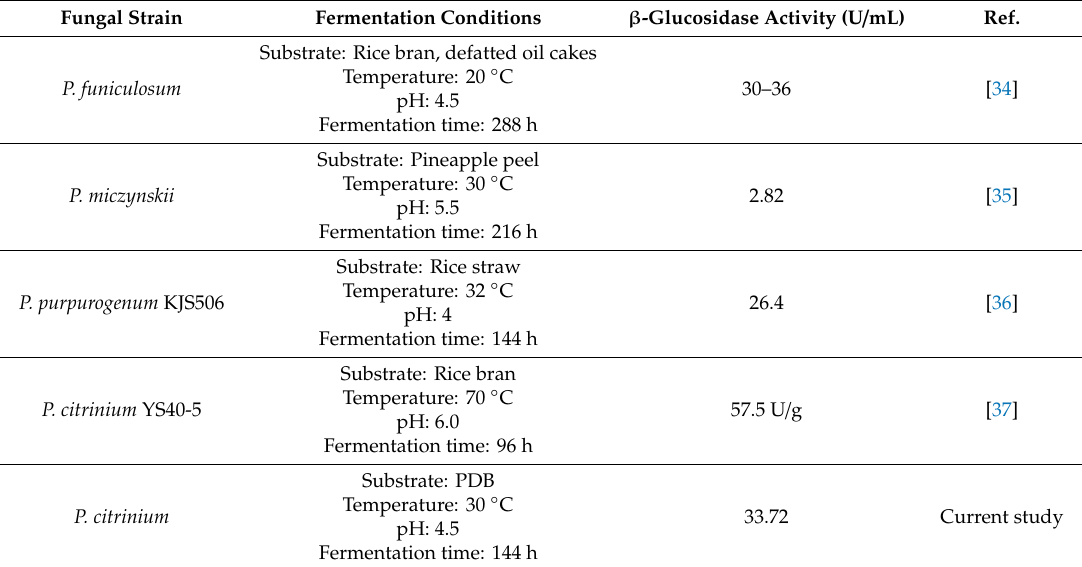
Table 3. β -glucosidase production of several fungal